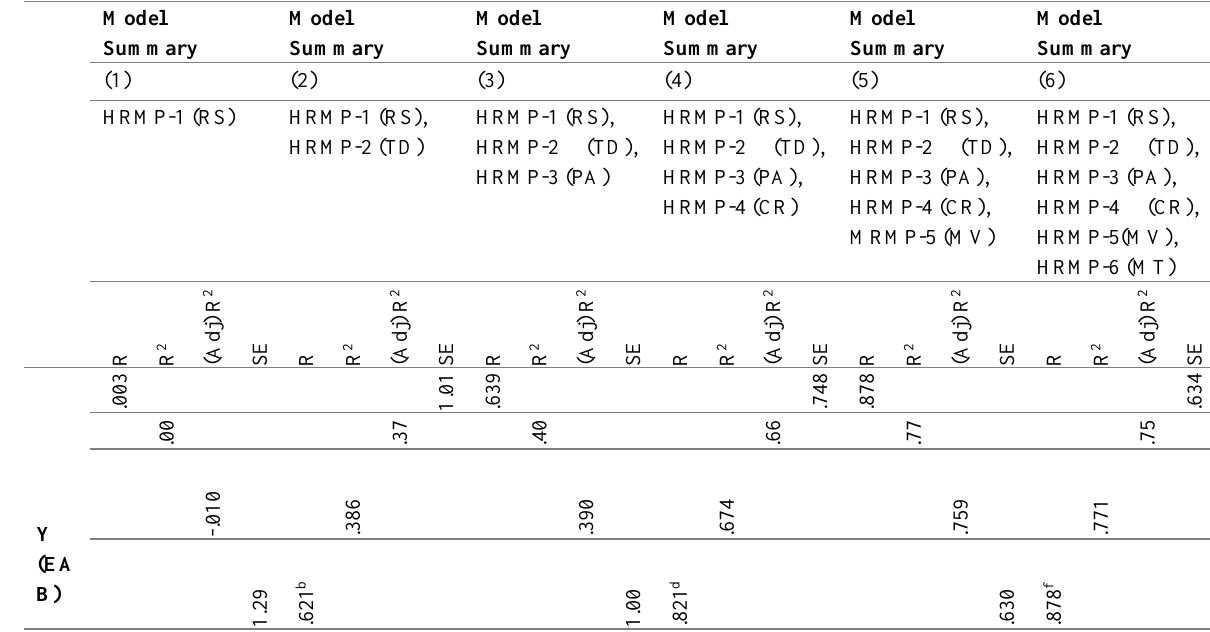
Table 3: Impact of HRMP-1 (RS), HRMP-2 (TD), HRMP-3 (PA), HRMP-4 (CR), HRMP-5 (MV) and HRMP-6 (MT) on Y (EAB)